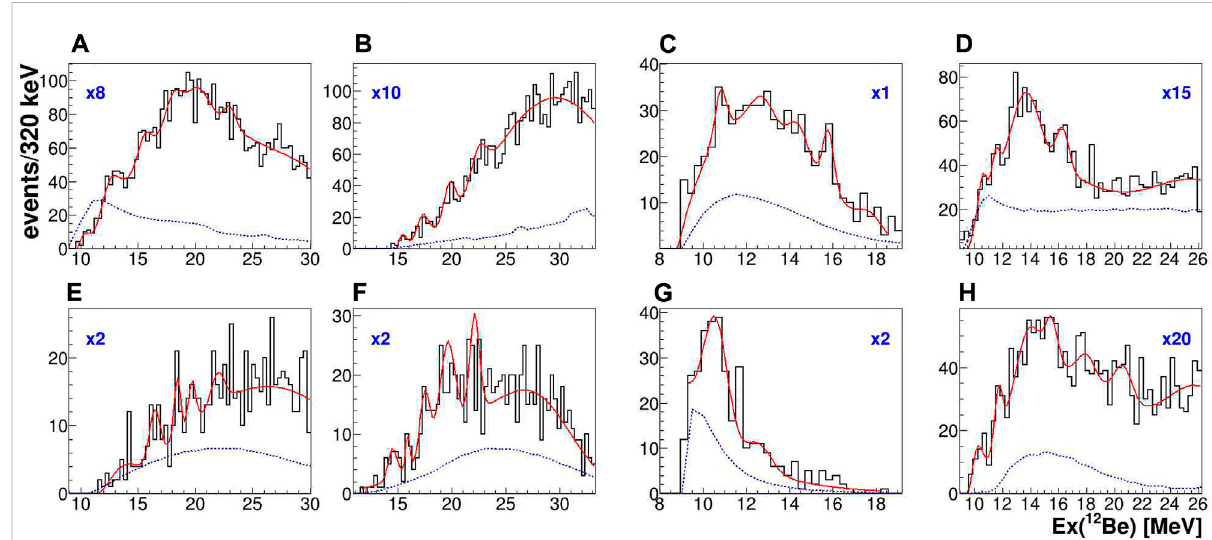
FIGURE 6 Examplesofthe 12 Beexcitationenergyspectraforthe 4 He+ 8 Hedecay.Spectraarereconstructedforthe 4 He+ 8 HecoincidencesfordT=3and 8 He paired with undetected 4 He (A) and detected 4 He (B) ; 4 He + 8 He coincidences for dT = 1 and 8 He paired with detected 4 He (C) ; 4 He + 4 He coincidences for dT = 3 and summed contributions of the 8 He paired with undetected and detected 4 He (D) ; 4 He + 8 He coincidences for dT = 2 and 8 He paired with undetected 4 He (E) and detected 4 He (F) ; 4 He + 8 He coincidences for dT = 0 and 8 He paired with detected 4 He (G) ; 4 He + 4 He coincidencesfordT=2andsummedcontributionsofthe 8 Hepairedwithundetectedanddetected 4 He (H) .Solidredcurvesareresultsofthebest fi t using Gaussian curves for the peaks on the estimated background. Dotted blue curves represent the detection ef fi ciency calculated by Monte Carlo simulations multiplied by the labeled